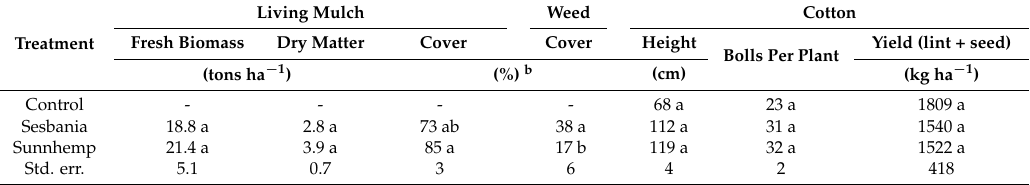
Table 3. Least squares means of cotton, living mulch and weed parameters from sesbania and sunnhemp data pooled across Years 1 and 2, and Sites 1 and 2 a .